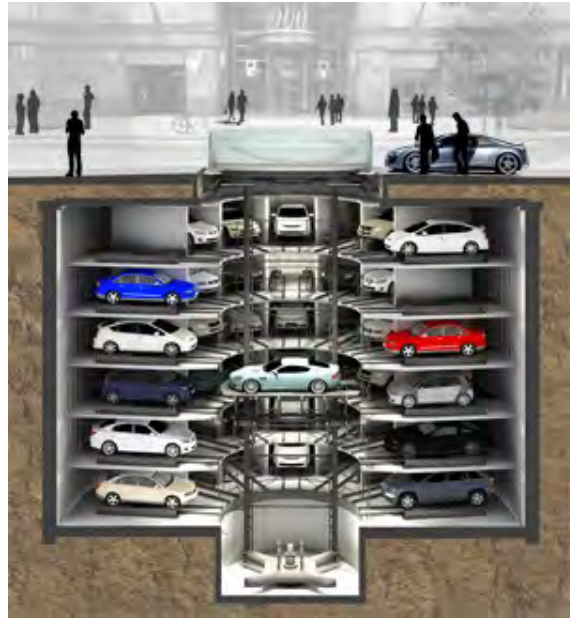
Figure 11. (APS) under the land. (PerfectPark, 2018)